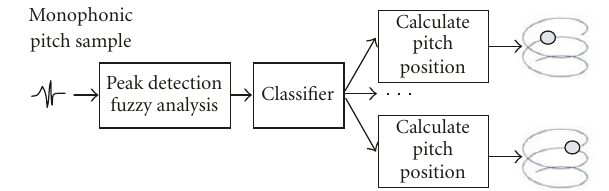
Figure 6: System diagram of reconstructing pitches in spiral array model.